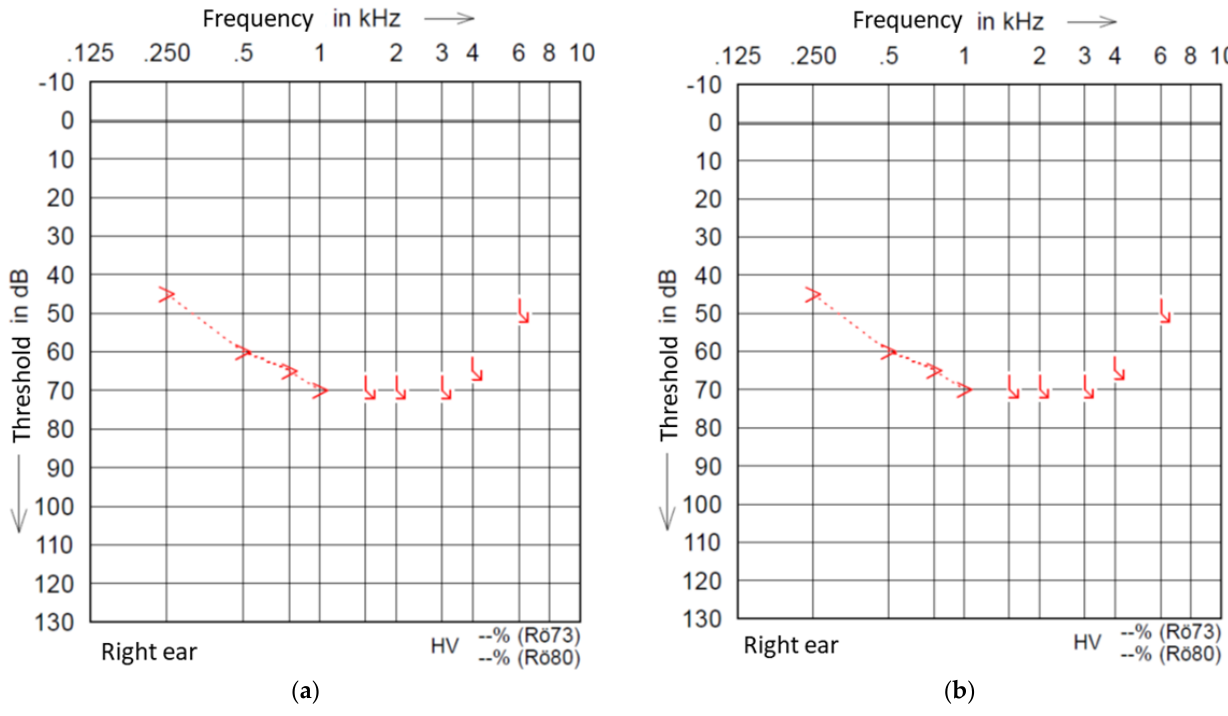
Figure 1. ( a ) Example pre-scanning PTA of Pat. 6. ( b ) Example post-scanning PTA of Pat. 6